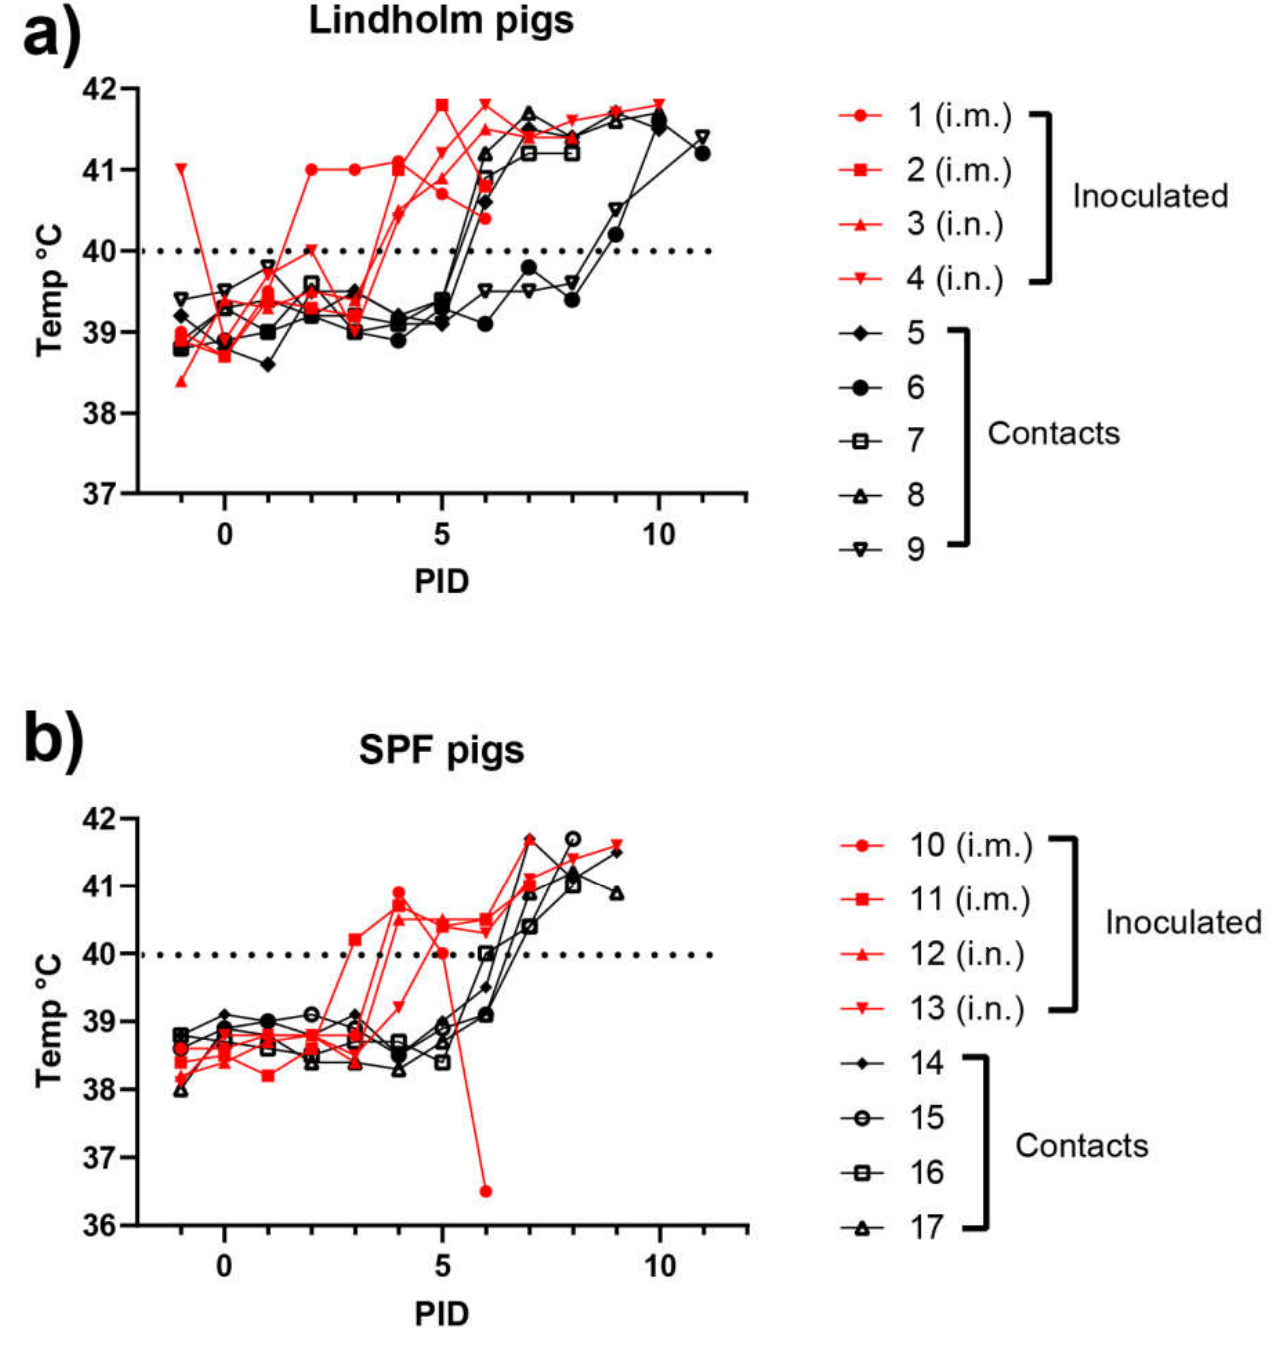
Figure 1. Rectal temperatures of ASFV-infected pigs using animals obtained from Lindholm’s herd ( a ) or from a commercial supplier of SPF pigs ( b ). At PID 9 (SPF pigs) or PID 12 (Lindholm pigs), the experimental studies were termi- nated. At PID 6, the first pigs (i.m. inoculated) died. In the following days, in total, five pigs died and the remaining 12 pigs were euthanized due to animal welfare